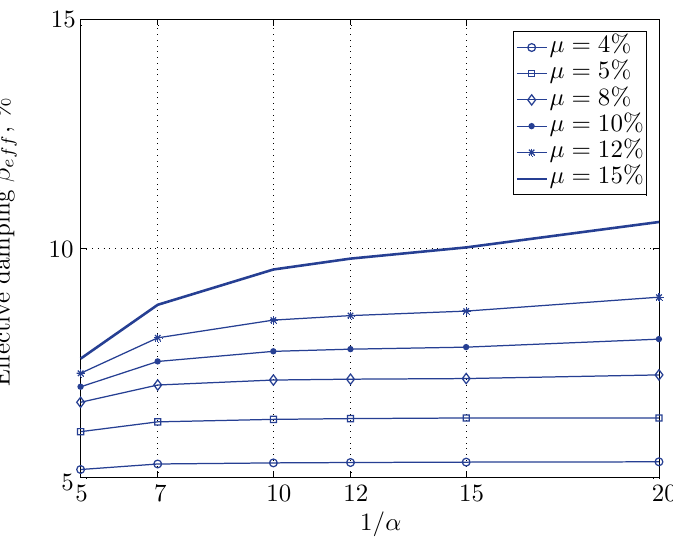
Figure 40. Effective damping for various isolation system parameters (Sylmar).